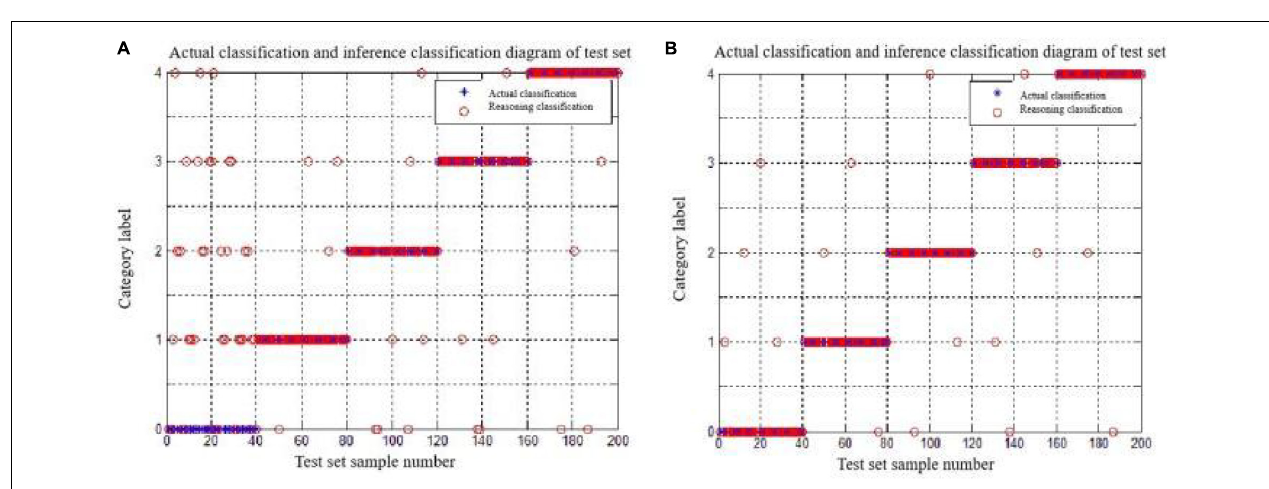
FIGURE 10 | The discriminant classification results for the test set. (A) “PX and PY.” (B) “PX,PY and SA.”